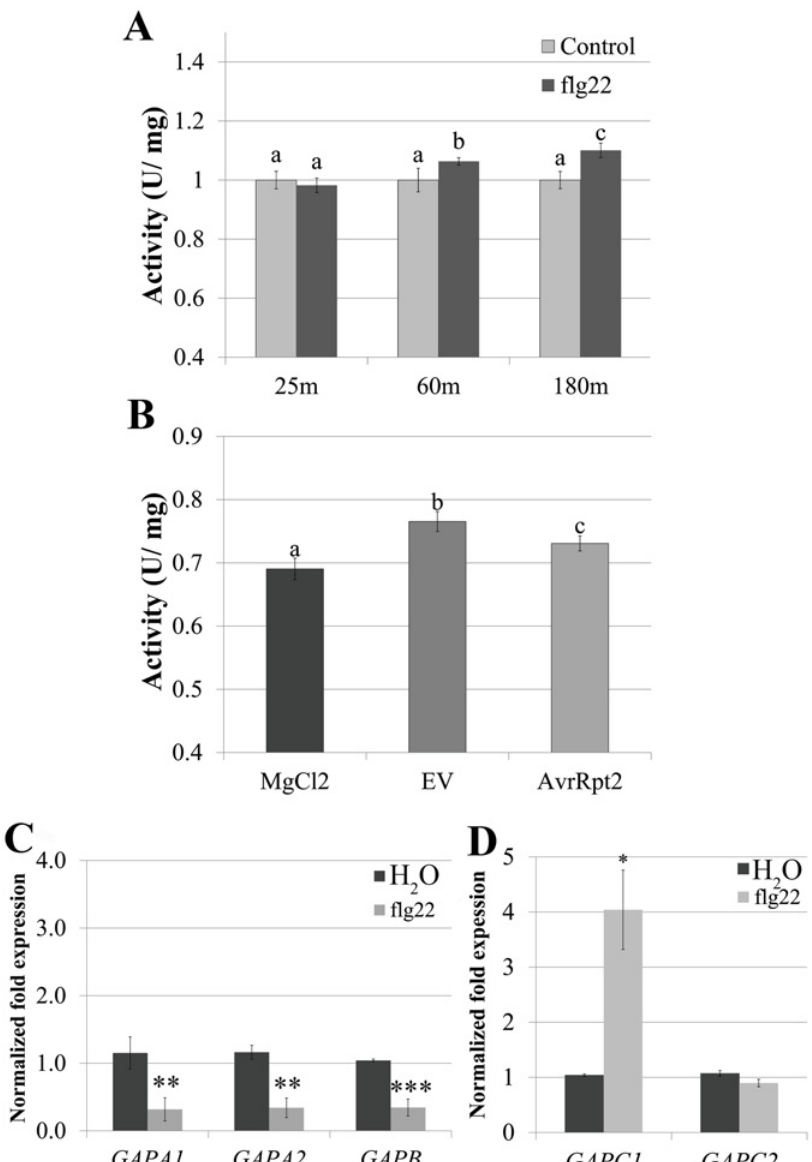
Fig 4. GAPDH transcription and enzymatic activity dynamically change during immune responses. ( A) GAPDH glycolytic activity assays were performed on four-week-old Col-0 after syringe infiltration with 5 μ M flg22 or H 2 O at 25 min, 60 min, and 180 min post-infiltration. Statistical differences were detected by a two-tailed Student ’ s t test ( α = 0.01) compared to water-treated samples at each time point. (B) Col-0 was infiltrated with 4×10 7 CFU mL-1 Pst DC3000 AvrRpt2 , DC3000 empty vector (EV) or MgCl 2 . Samples were harvested for the glycolytic activity assay 8h post-infiltration. Statistical analyses were performed as described in (A). (C-D) Quantitative PCR (qPCR) analyses of four-week-old Col-0 leaves 3h post-infiltration with 5 μ M flg22 or water. (C) and (D) segregate separate qPCR runs. Values represent means ± SE (n = 3). Statistical differences were detected by a two-tailed Student ’ s t test ( α = 0.01, and 0.001) compared to H 2 0 treated controls. Data were analyzed using the ΔΔ cT method, and normalized against Arabidopsis ELONGATION FACTOR 1 α